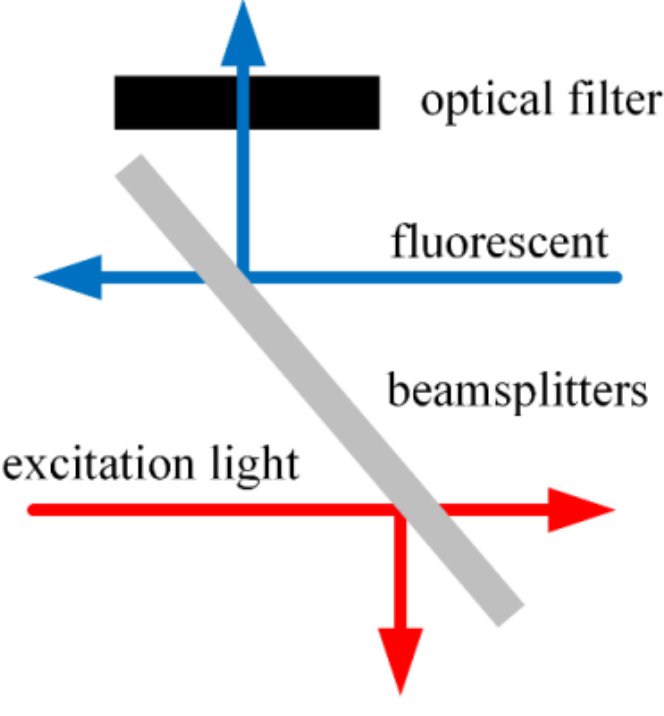
Figure 6. Schematic diagram of cross section of conductive optical path.